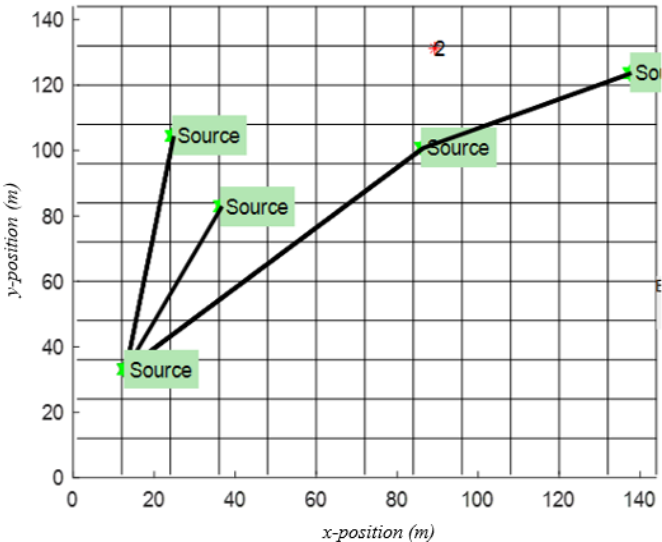
Figure 12. UAV Connectivity Routing.